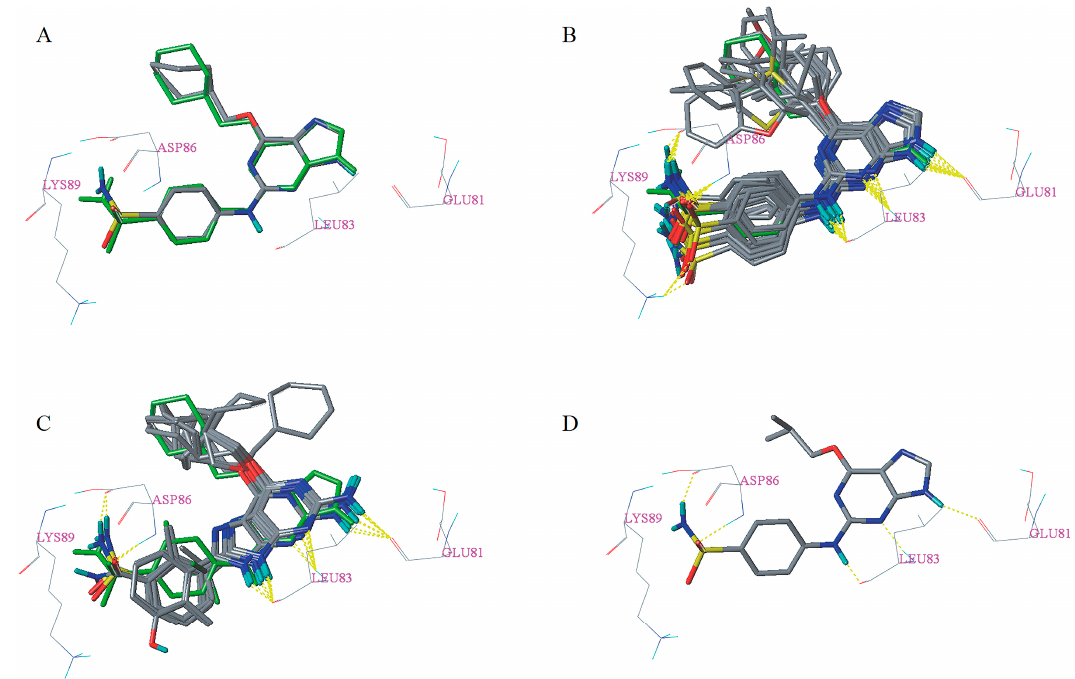
Figure 5. Re-docking result of the cognate ligand ( A ) and docking results of dataset compounds ( B , C ) and compound 9 ( D ). The cognate ligand was displayed in the green stick model. Hydrogen bonds were shown as yellow dashed lines and non-polar hydrogens were removed for clarity.